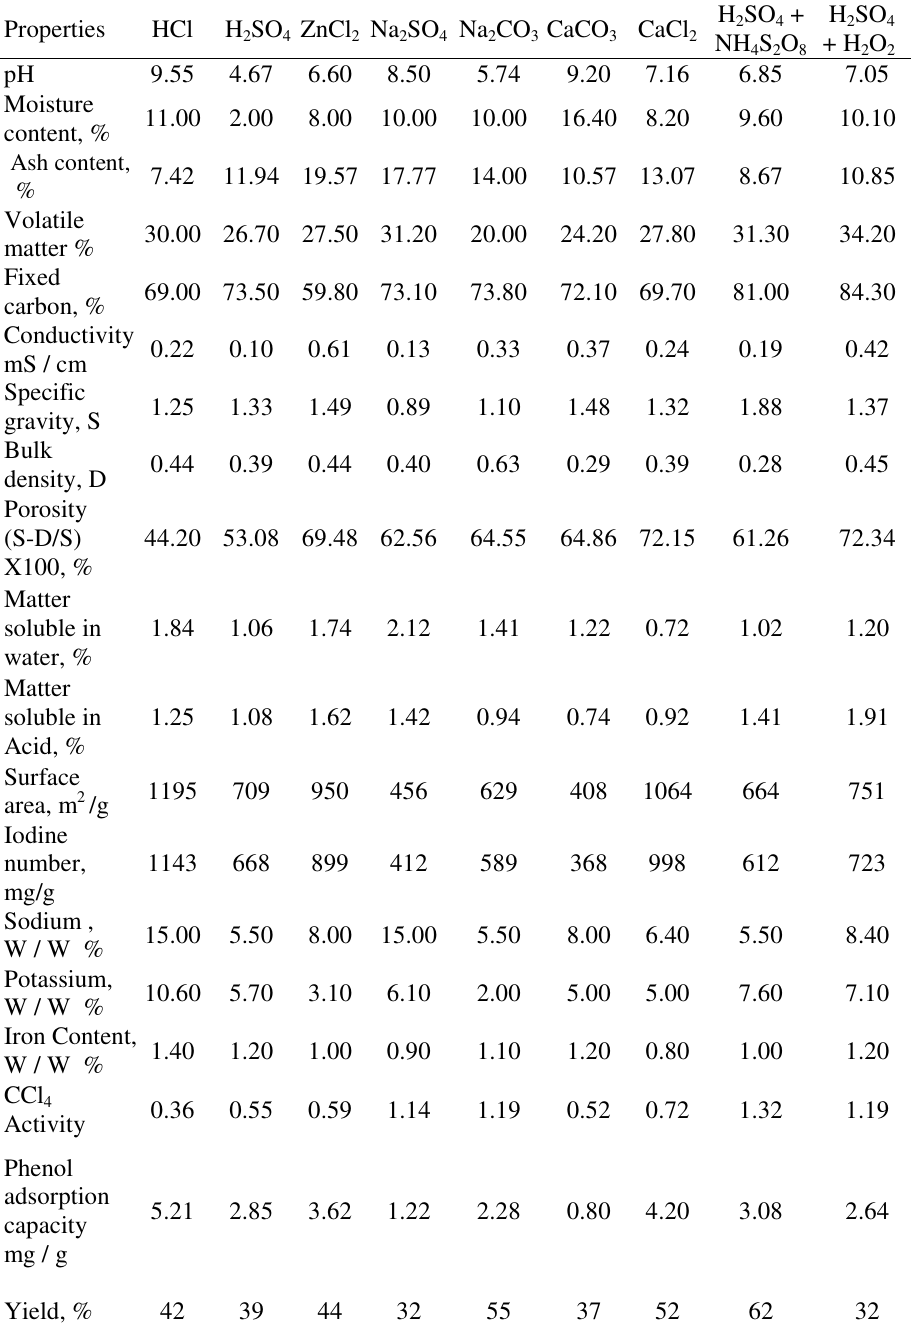
Table 2 Jatropha curcus seed shell waste activated carbon